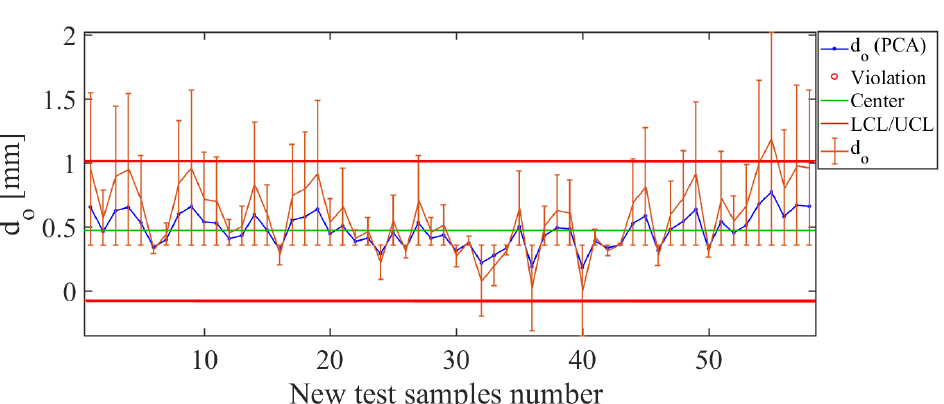
Figure 21. Soft-sensor response (control chart and error bars) for the operating condition d 0 . Note the low estimation level for values close to d 0 = 1.0 mm of this operating condition.